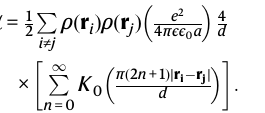
Fig.1|ElectronicstatesinTMDMoirésystems.a Theredandbluedotsshowthe sites of two honeycomblatticeswhose lattice constantsdiffer by5%.Theselattices are layered at zero twist-angle, resulting in an emergent triangular Moiré lattice with a unit cell indicated by the black lines. In the case of TMD heterobilayers, the Moiré lattice has point group C 3 . b Top: optical anisotropy as a function of Moiré lattice fi lling, reproduced with permission from ref. 16. Bottom: charge order pat- terns at 1/3-, 2/5-, and 1/2- fi lling as determined by Monte Carlo, reproduced with permissionfromref.7. c HereweshowtheMoiréunitcellwithoccupiedlatticesites representedbybluedots,andthebond connectingnearestneighborpairscolored according to its orientation. On a lattice with C 3 symmetry, there are two distinct types of nematic states. Type-I nematics (left) have a nematic director oriented alongasinglemajoritybond orientationat θ ∈ {0, π /3,2 π /3}andhave h cos ð 6 θ Þi =1.